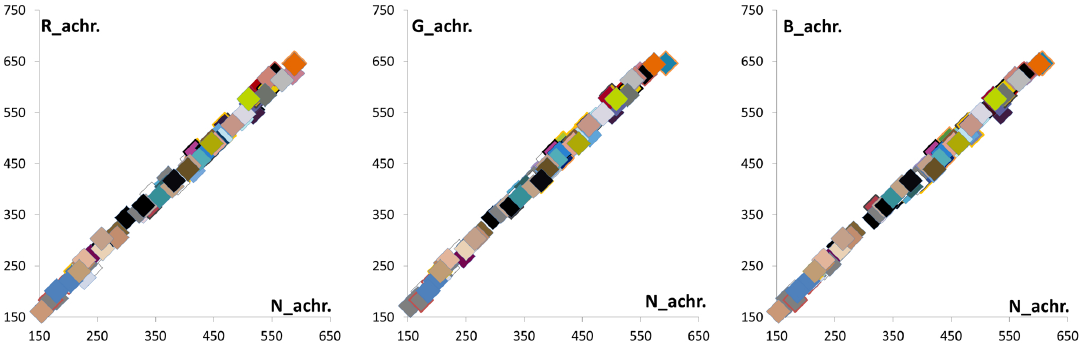
Figure 5. Correlation between the RGB channel and the N channel in the NIR band beyond 800